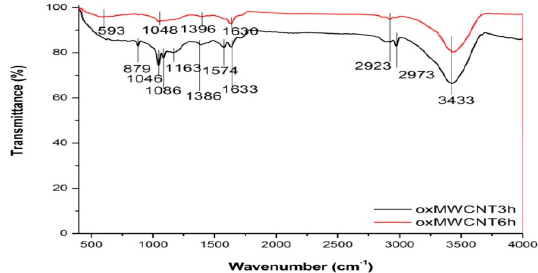
Figure 2. FTIR spectra of oxMWCNT3h and oxMWCNT6h.